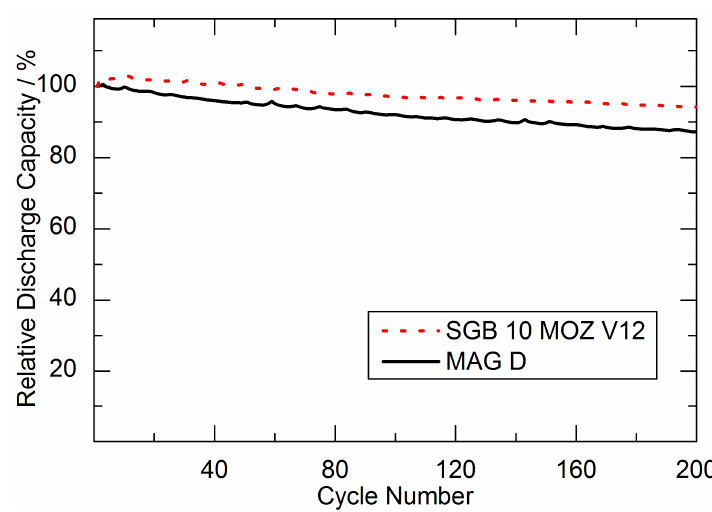
9 of 15 Figure 5. Relative discharge capacities at a 1 C-rate of full-cells assembled with cathodes representing all combinations of ageing conditions and solvents used for slurry preparation. The highest specific discharge capacity (120.6 mAh·g − 1 , observed for full-cells assembled with water-based cathodes produced with LFMP aged at 40 °C and 100% rh) was set to 100% and all other discharge capacity into relative relation to this value. Legend indicates the solvent used for slurry preparation and the initial powder sample storage conditions are in brackets. The left side of the graph shows the C-rate test before the long-term cycling. Prior to the C-rate test the discharge capacities are mainly equal, but after the C-rate test water-based full-cells tend to have a better capacity recovery. Their fading rate is slightly higher during the first 80 cycles but then converges with the one of NMP-based full-cells leading to a parallel curves and similar long-term discharge behavior.